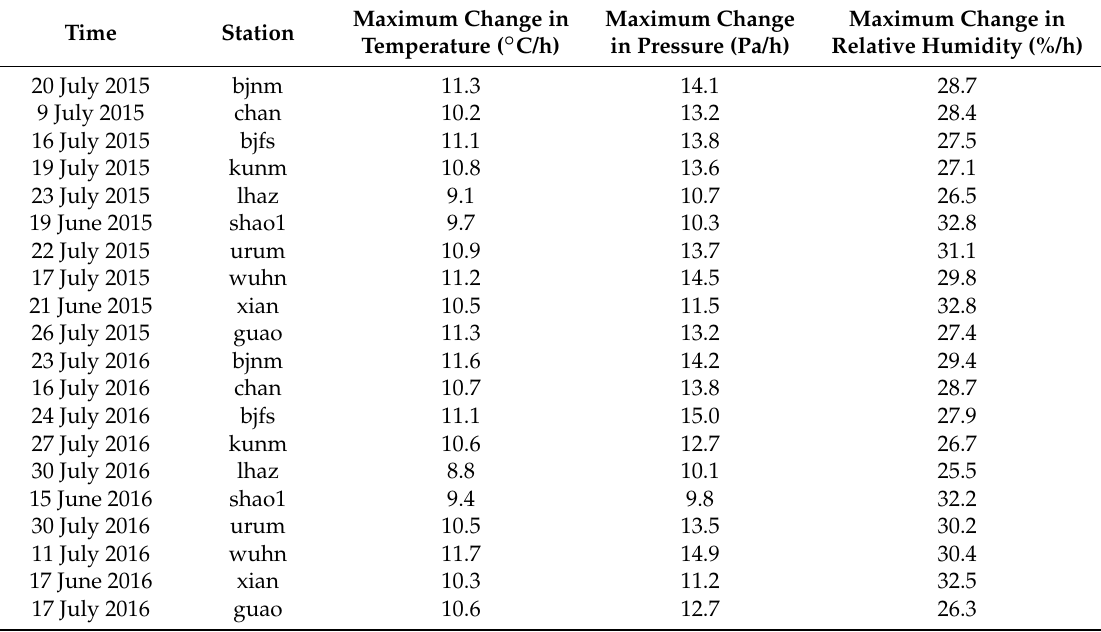
Table 2. The most serious troposphere anomalies at 10 IGS stations in